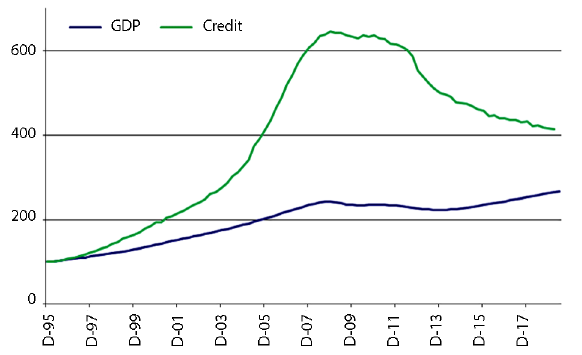
Figure 2. Credit to households and firms. Spain, 1996–2017 (1996 base = 100) To target a dataset of SEs that is representative of the Galician economy, we start with the sectoral distribution. Following the Galician Statistics Institute (IGE) classification of municipalities by its degree of urbanization, based on Eurostat’s DEGURBA standards, 242 of them are rural (of a total of 315 in year 2016). That year, the largest sectors by number of firms were agriculture, forestry and fishing sectors (11.2%), food and beverages (3.9%), con- struction and specialized construction (18.2%), wholesale trade (9.9%), retail trade (9.2%), and hotels and restaurants (6.9%). We focus on the most relevant: agrifood (NACE 1, 2, 3, 10, 11), manufacturing of wood and metal (NACE 16, 25), construction of buildings (NACE 41), wholesale trade (NACE 46), and the retail trade sector (NACE